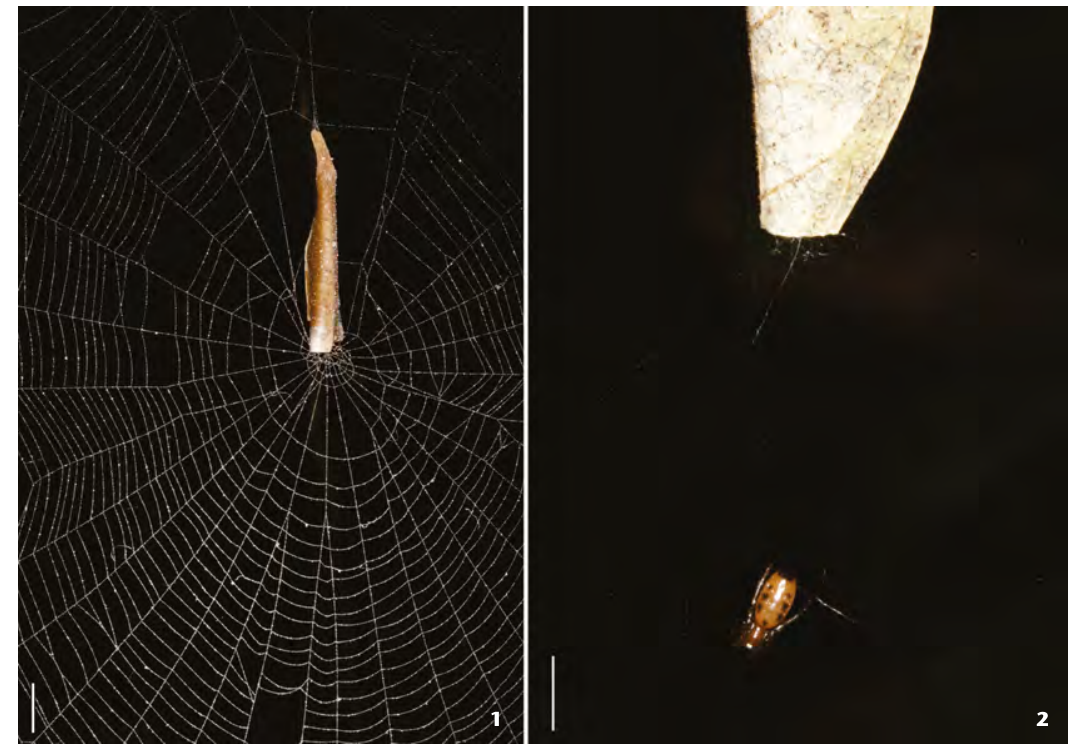
Figures 1-2. Hingstepeira folisecens orb web in an area of the Amazon forest, Brazil: (1) vertical orb web with the rolled dry leaf used as a shelter by the spider attached to the hub; (2) shelter’s detail showing the entrance oriented just downwards and the spider leaving it. Scale bars: 1 = 10 mm, 2 = 5